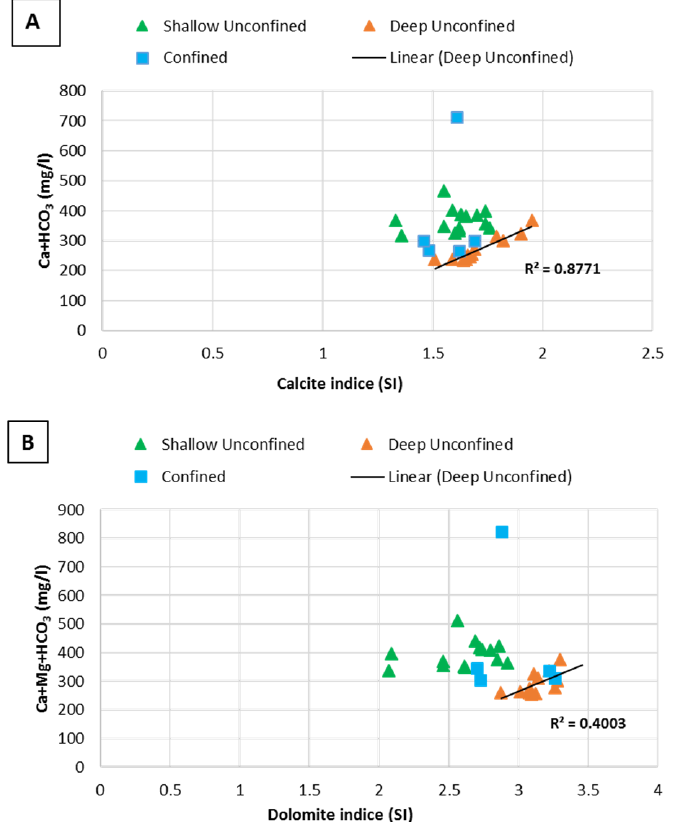
Figure 10. Scatter plots showing the relationship between ( A ) calcite SI and Ca + HCO 3 , ( B ) dolomite SI and Ca + Mg + HCO 3 .